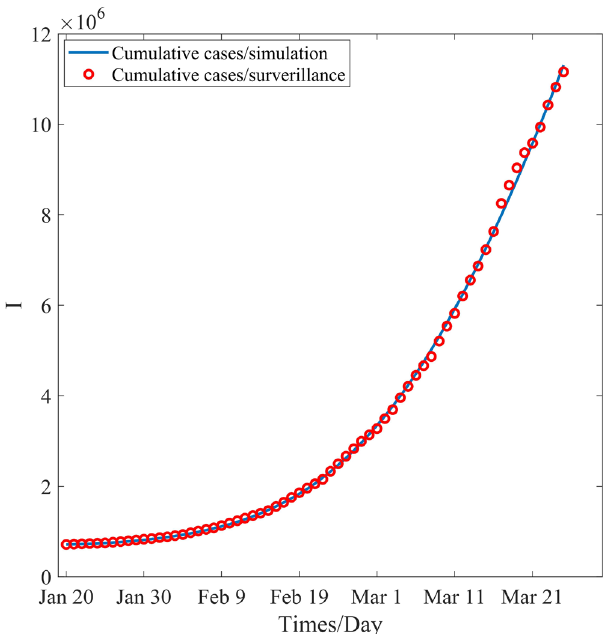
Figure 1. Numerical fitting of the cumulative